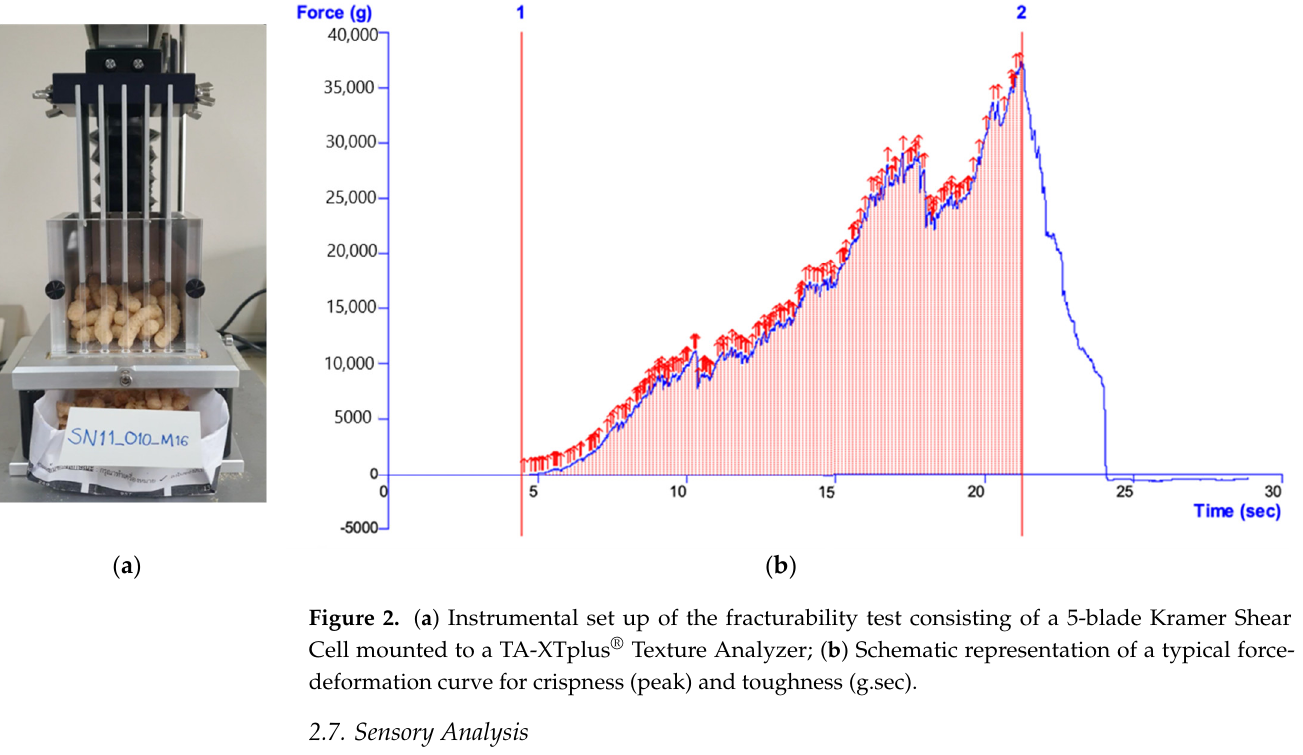
Figure 1. Detailed view of the sample holder with PDMS pins: ( a ) empty; ( b ) sample after measurement.